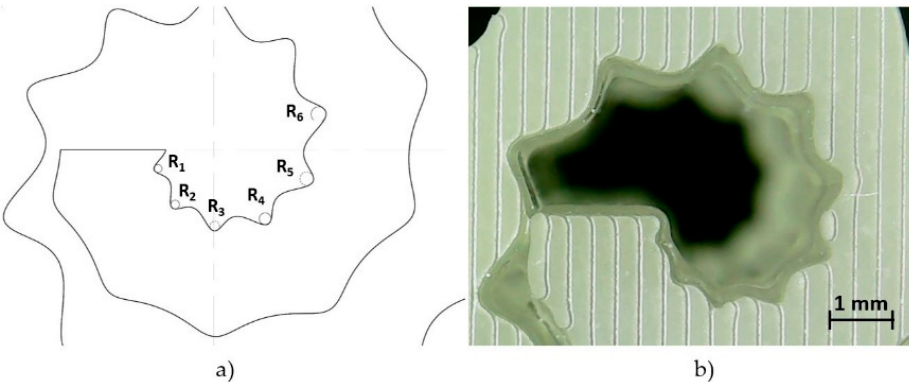
Figure 4. Geometric characterization of the SSDRA: ( a ) evidence of the radii (from R1 to R6) approx- imating the hollows of the internal SsDRA curve; ( b ) image acquisition of the same micro-features close to the SsDRA’s origin.